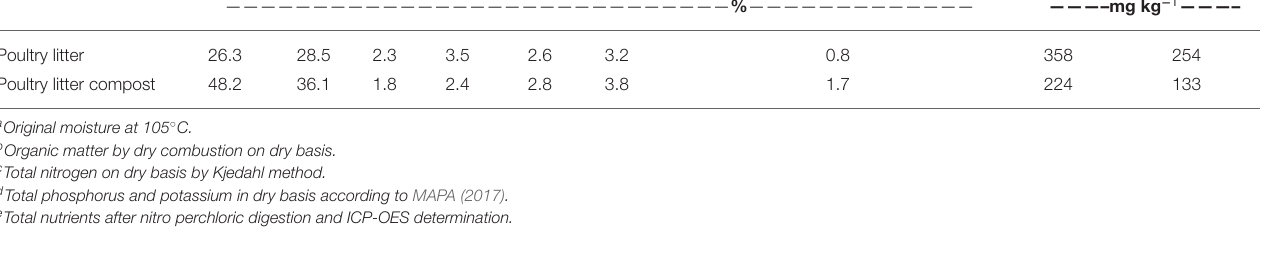
TABLE 1 | Poultry litter and poultry litter compost characterization. Organic material Moist. a